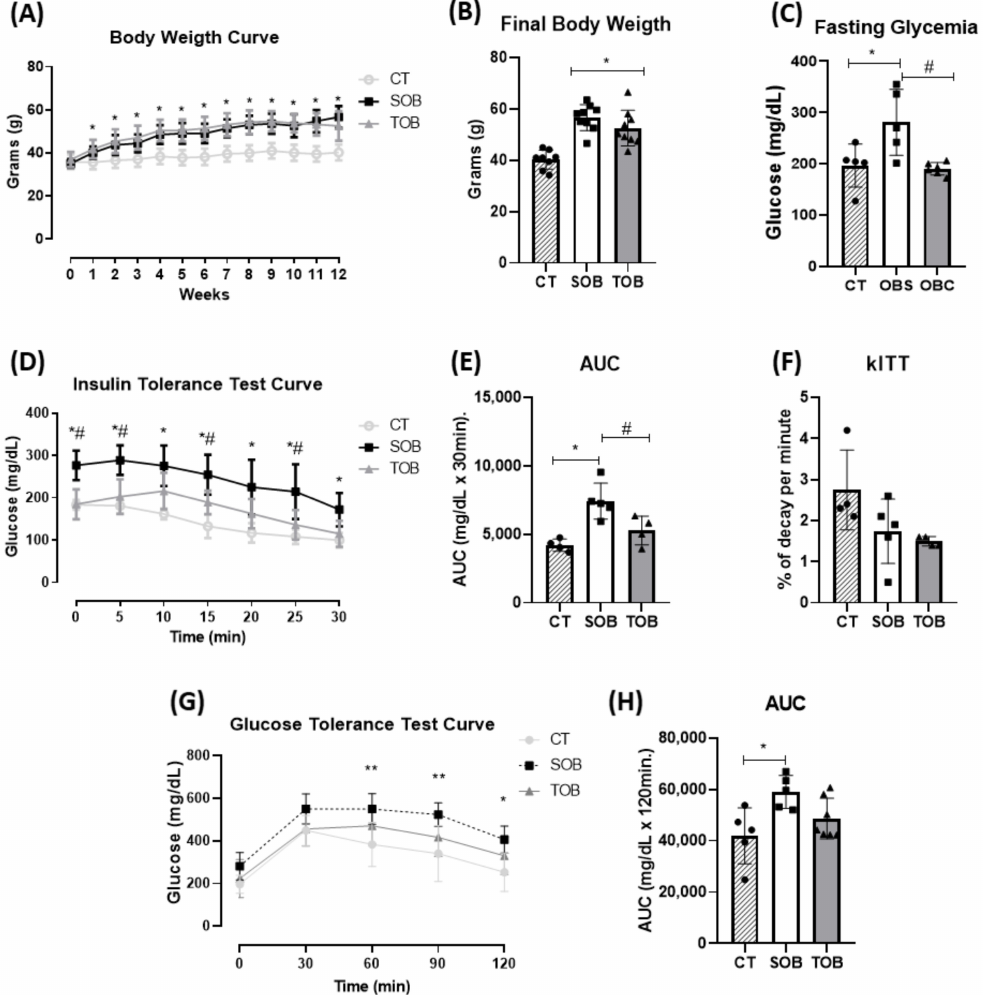
Figure 1. Physiological and metabolic parameters. ( A ) Body weight curve during 12 weeks of diet induction. ( B ) Final body weight. ( C ) Fasting glycemia (8 h fasting). ( D ) Glycemic curve during insulin tolerance test (ITT). ( E ) Area under the curve (AUC) during ITT. ( F ) Blood glucose decay rate (kITT) during ITT. ( G ) Glycemic curve during glucose tolerance test (GTT). ( H ) Area under the curve during GTT. The bars represent the mean ± SD of the control (CT), sedentary obese (SOB), and trained obese (TOB) groups ( n = 26 body weight; n = 4–5 per group in the test). * p < 0.05 vs. CT; ** p < 0.008 vs. CT; # p < 0.05 vs. TOB. For the results presented in the bar graphs, comparing the three groups at a single moment, we used one-way ANOVA ( B , C , E , F , H ), followed by Bonferroni’s post-hoc test. For the line graphs, which compared the three groups at di ff erent times, we used two-way ANOVA ( A , D , G ), followed by Bonferroni’s post-hoc